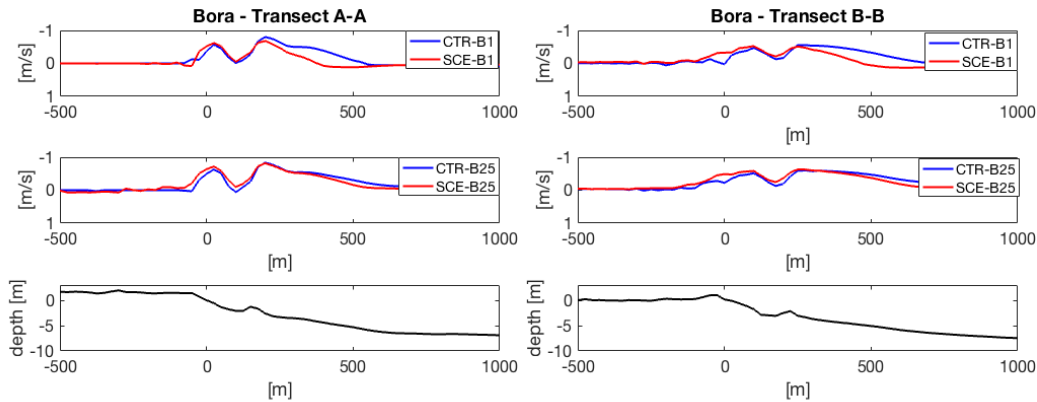
Figure 12. Bora events. Cross-shore distribution of the alongshore velocity as calculated by TEL2D for ordinary B1 and extreme B25 events, and of the water depth along transect A-A ( left panels ) and transect B-B ( right panels ).